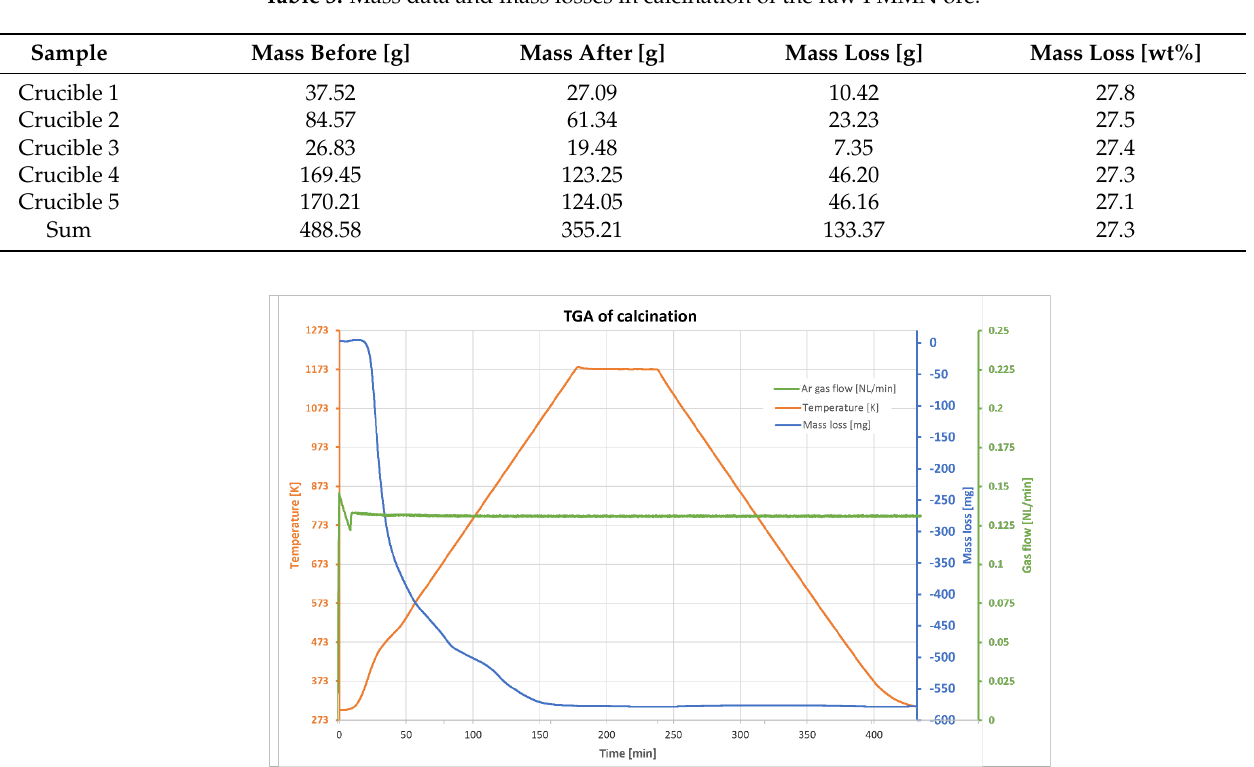
Table 3. Mass data and mass losses in calcination of the raw PMMN ore.